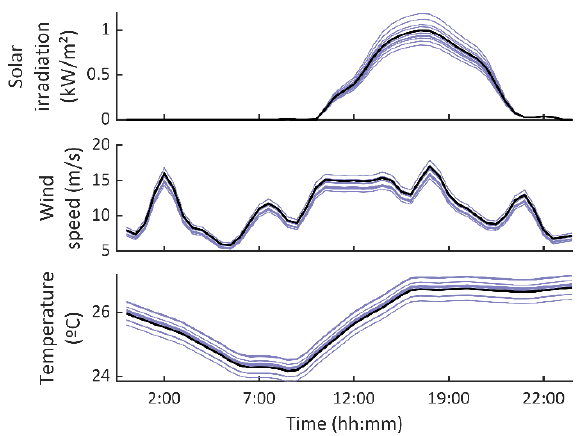
Figure 4. Weather forecast (black) and considered scenarios (blue) in simulations.